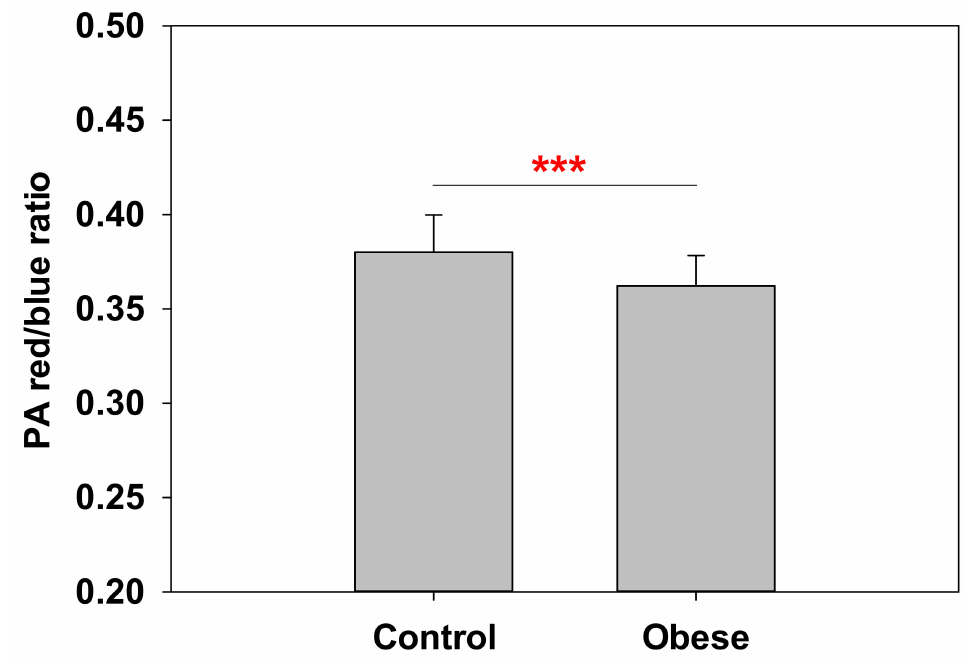
Figure 7. PA probe measurements of blood plasma. Red/blue intensity ratio (RBIR) values for control and obese blood plasma revealed a highly significant reduction in obese patients. Experiments performed at 37 ◦ C ( n = 35 for control and n = 39 for obese). Average values ± S.D. Significance according to Student’s t-test: (***) p <